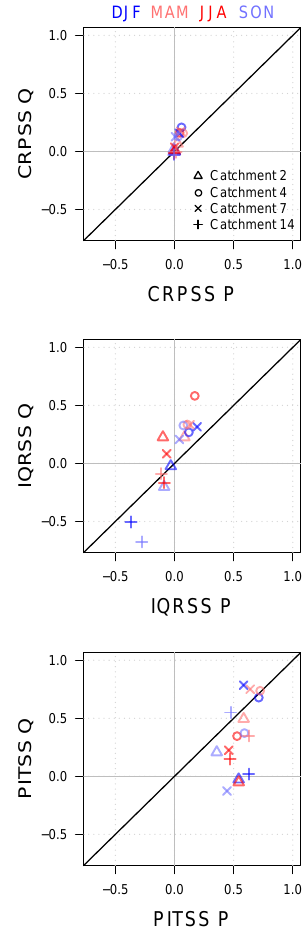
Figure 14. Skill scores of streamflow forecasts after correction with EDMD-m against skill scores of precipitation forecasts after cor- rection with EDMD-m. The skill score of forecasts corrected with EDMD-m is computed using raw forecasts as reference. It is then averaged over lead times of 10–90 days to obtain a single value. Results are shown for all four seasons in four selected catchments (catchments 2, 4, 7 and 14). Skill scores were obtained based on the CRPS (top), the IQR (middle) and the PIT diagram area (bot- tom). The 1:1 diagonal corresponds to an equivalent performance increase in precipitation and